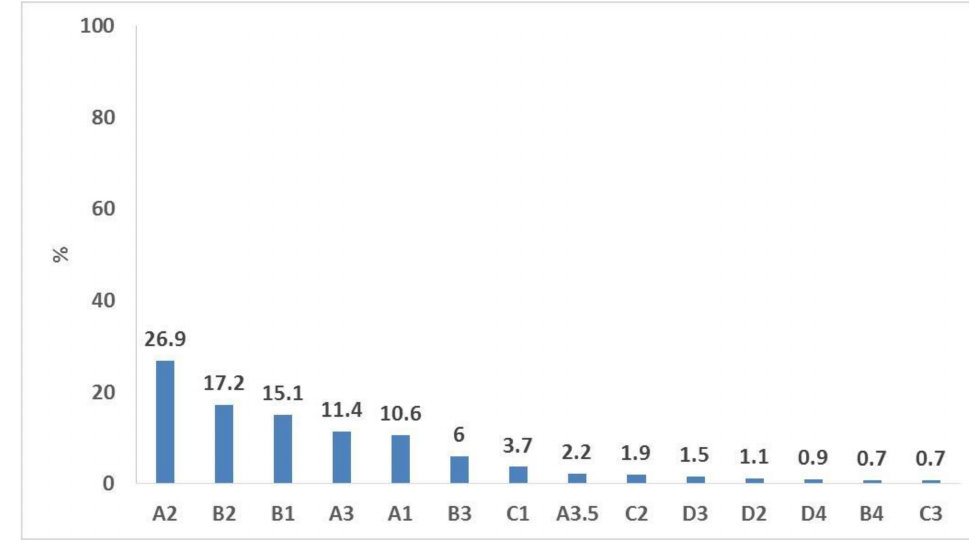
Figure 1. Self-perceived shades among the study participants.